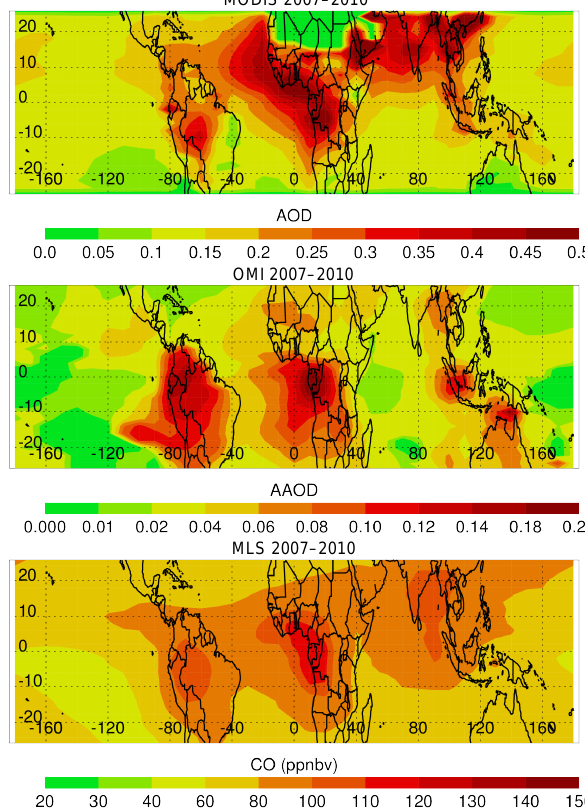
Figure 2. Average MODIS AOD, OMI AAOD, and MLS CO at 215hPa for 2007–2010.